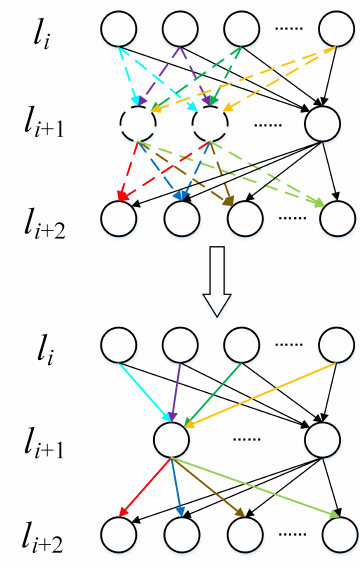
Figure 1. Agglomerating neurons in the fully connected layers.